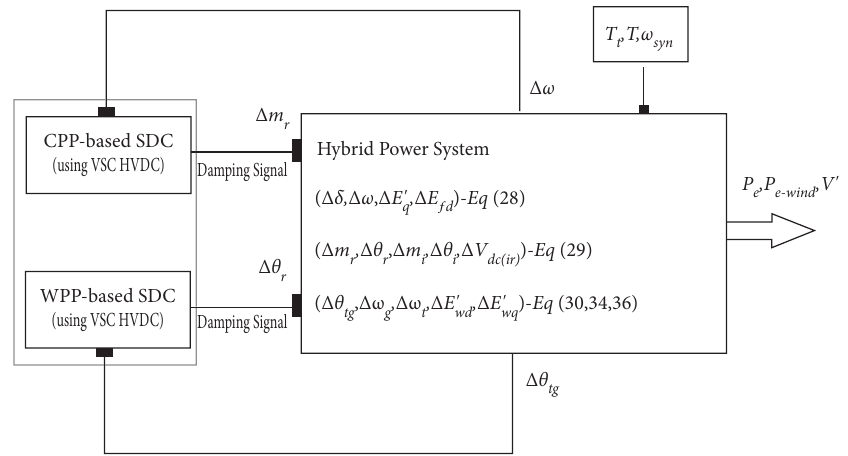
Figure 6: The proposed VSC HVDC-based